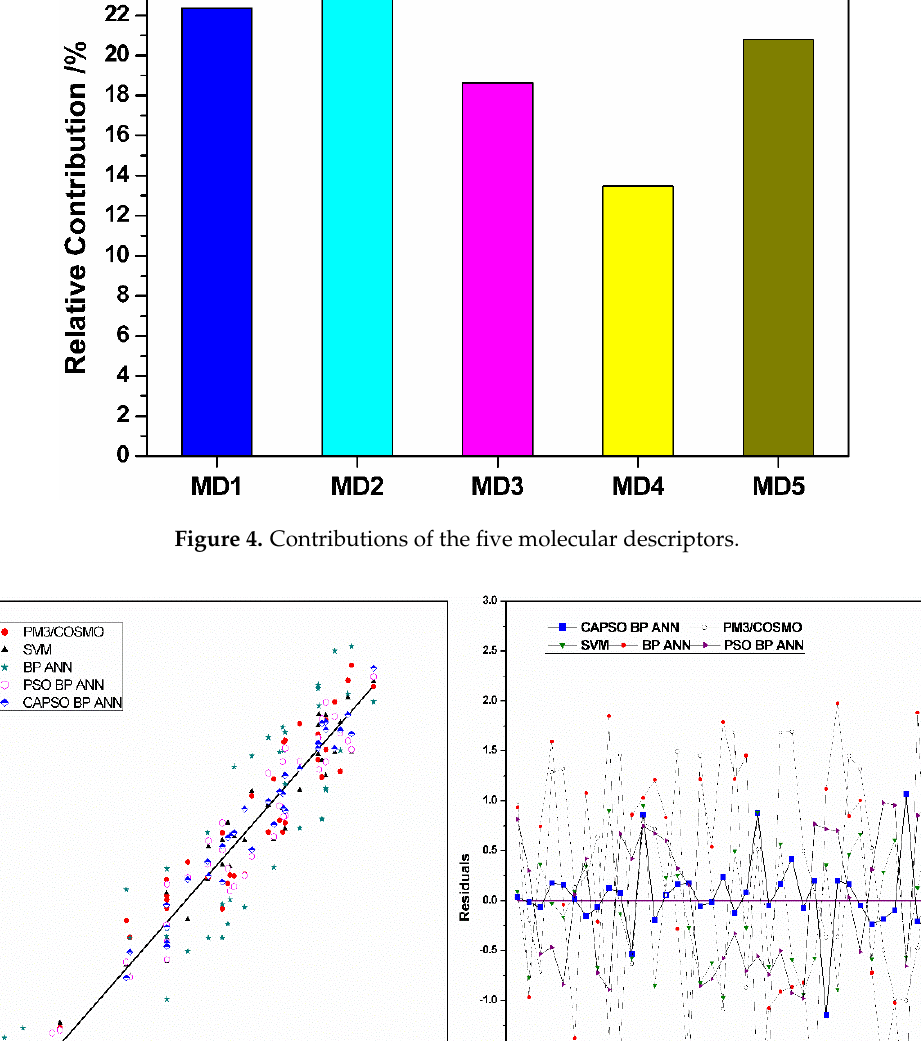
Figure 4. Contributions of the five molecular